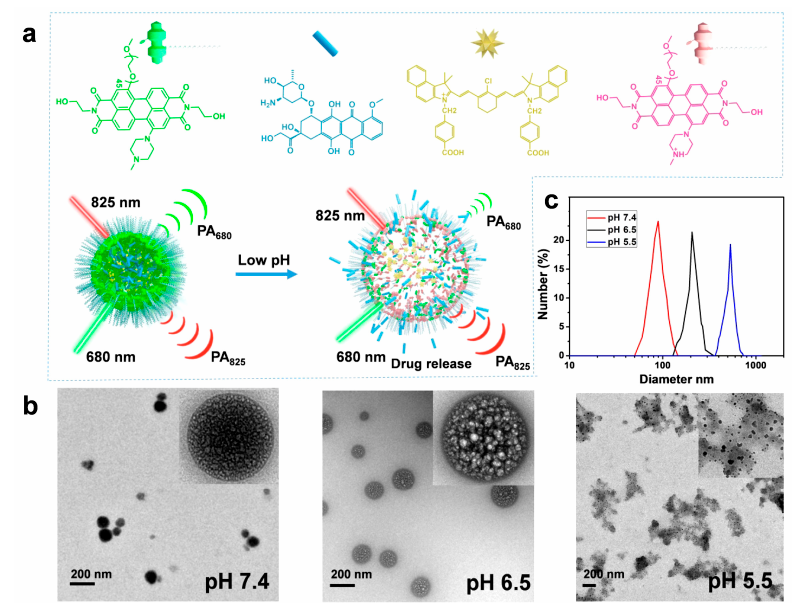
Figure 11. Chemical structures of small-molecule agents for NIR-I photoacoustic imaging.